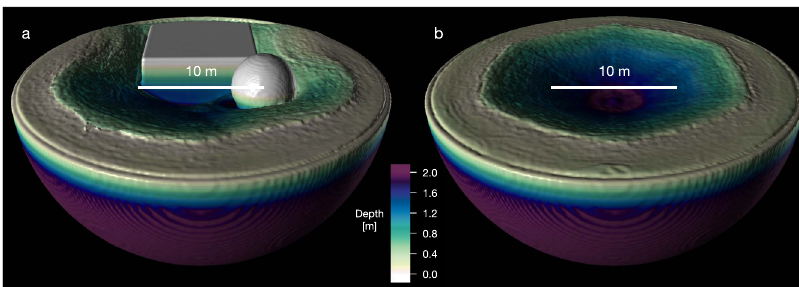
Fig. 3 | Comparison of SCI impact simulations with varying target surface properties.a Targetswithbouldersand b targetswithoutboulders,withotherwise the same impact conditions. In both cases, the homogeneous target material is